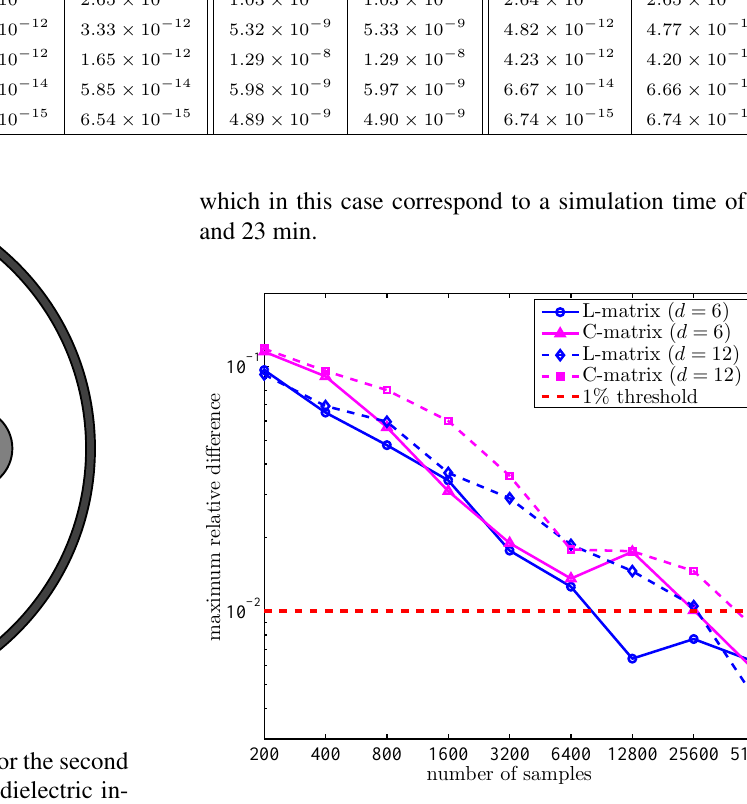
Figure 5: Convergence of the MC simulation for the stan- dard deviation of the p.u.l. parameters of the shielded cable.